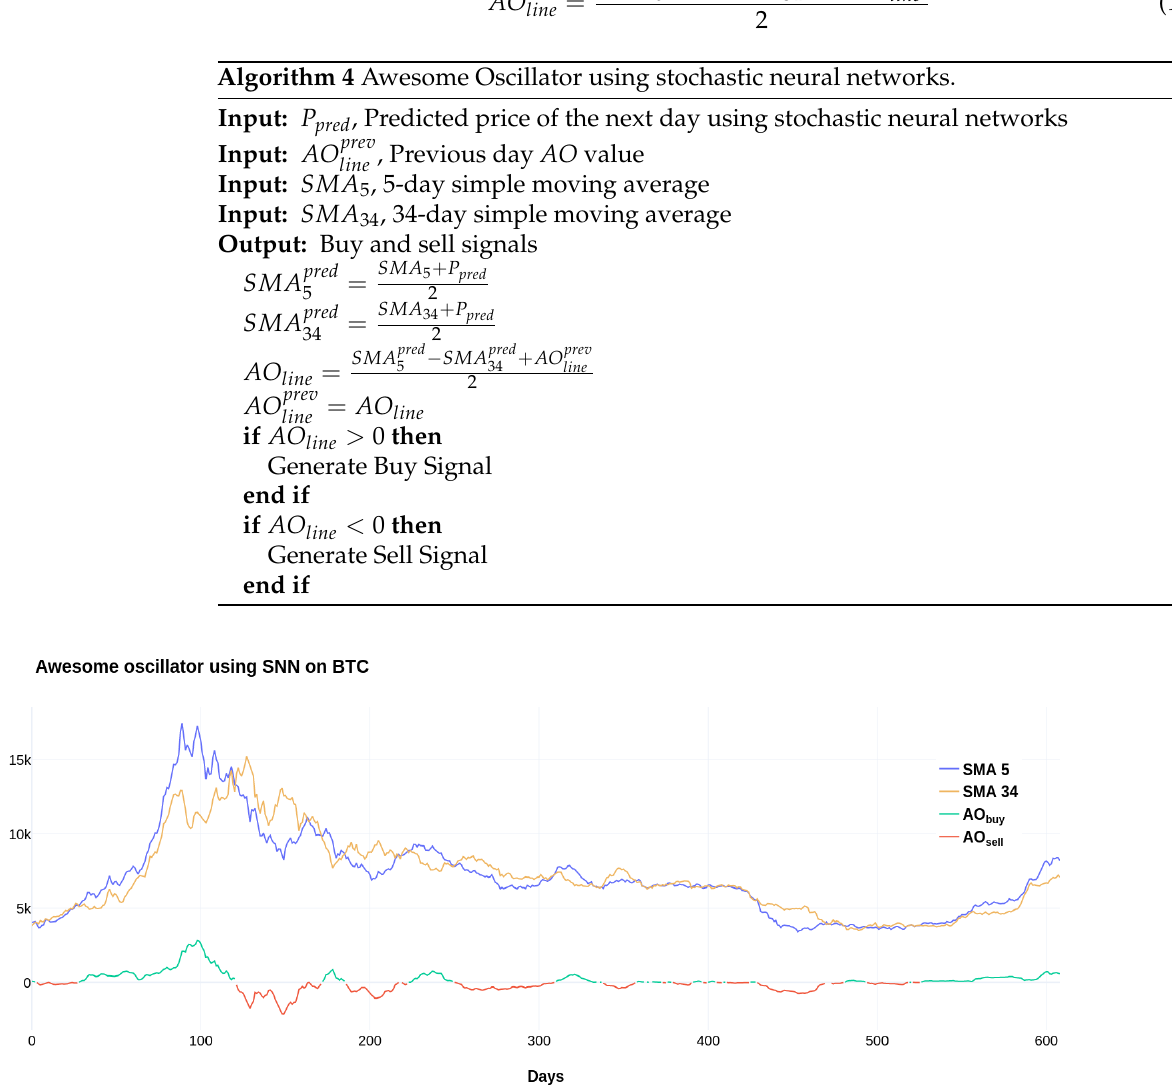
Figure 6. Awesome Oscillator strategy using SNN on